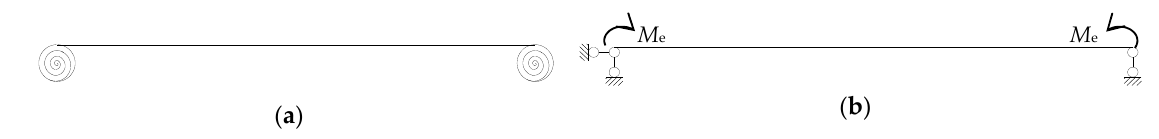
Figure 1. Calculation diagram: ( a ) a timber beam with semis-rigid support; ( b ) a simply supported beam with extra moment.